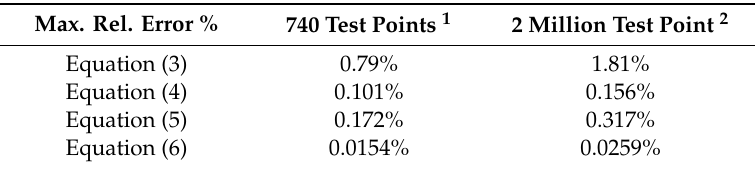
Table 2. Analysis of error performed in MS Excel with 740 points compared with analysis from Matlab with 2 million Monte Carlo samples using the Sobol sequence.